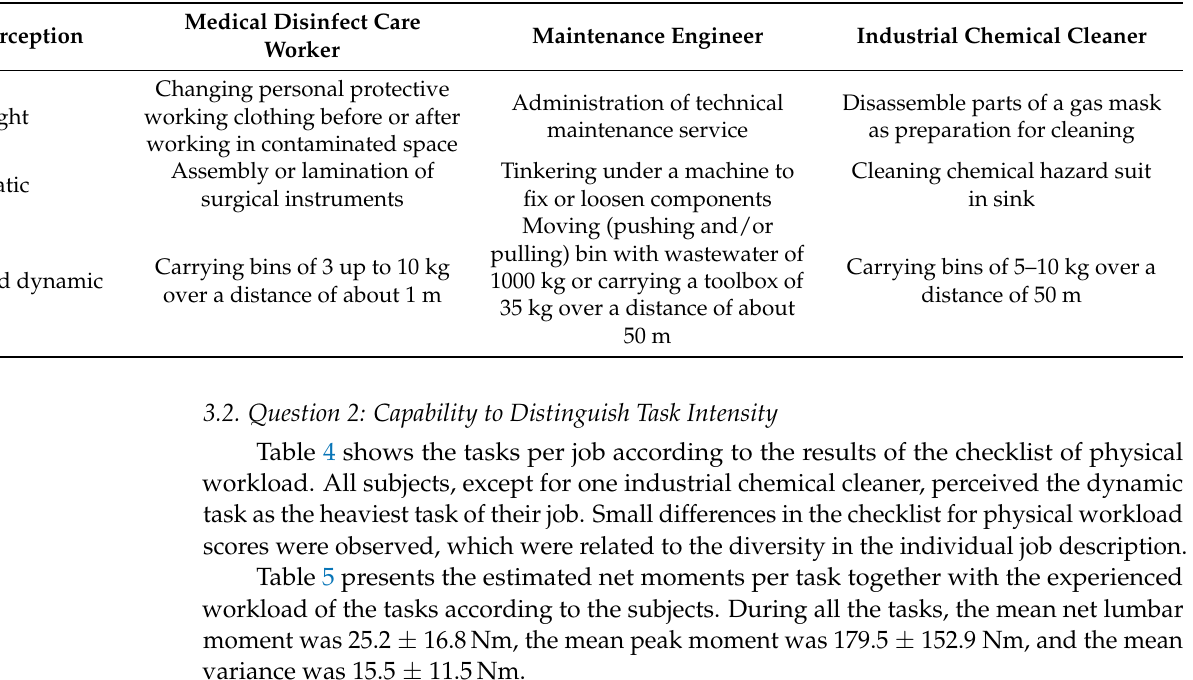
Table 4. Tasks per job type. Based on the results of the checklist for the physical workload.